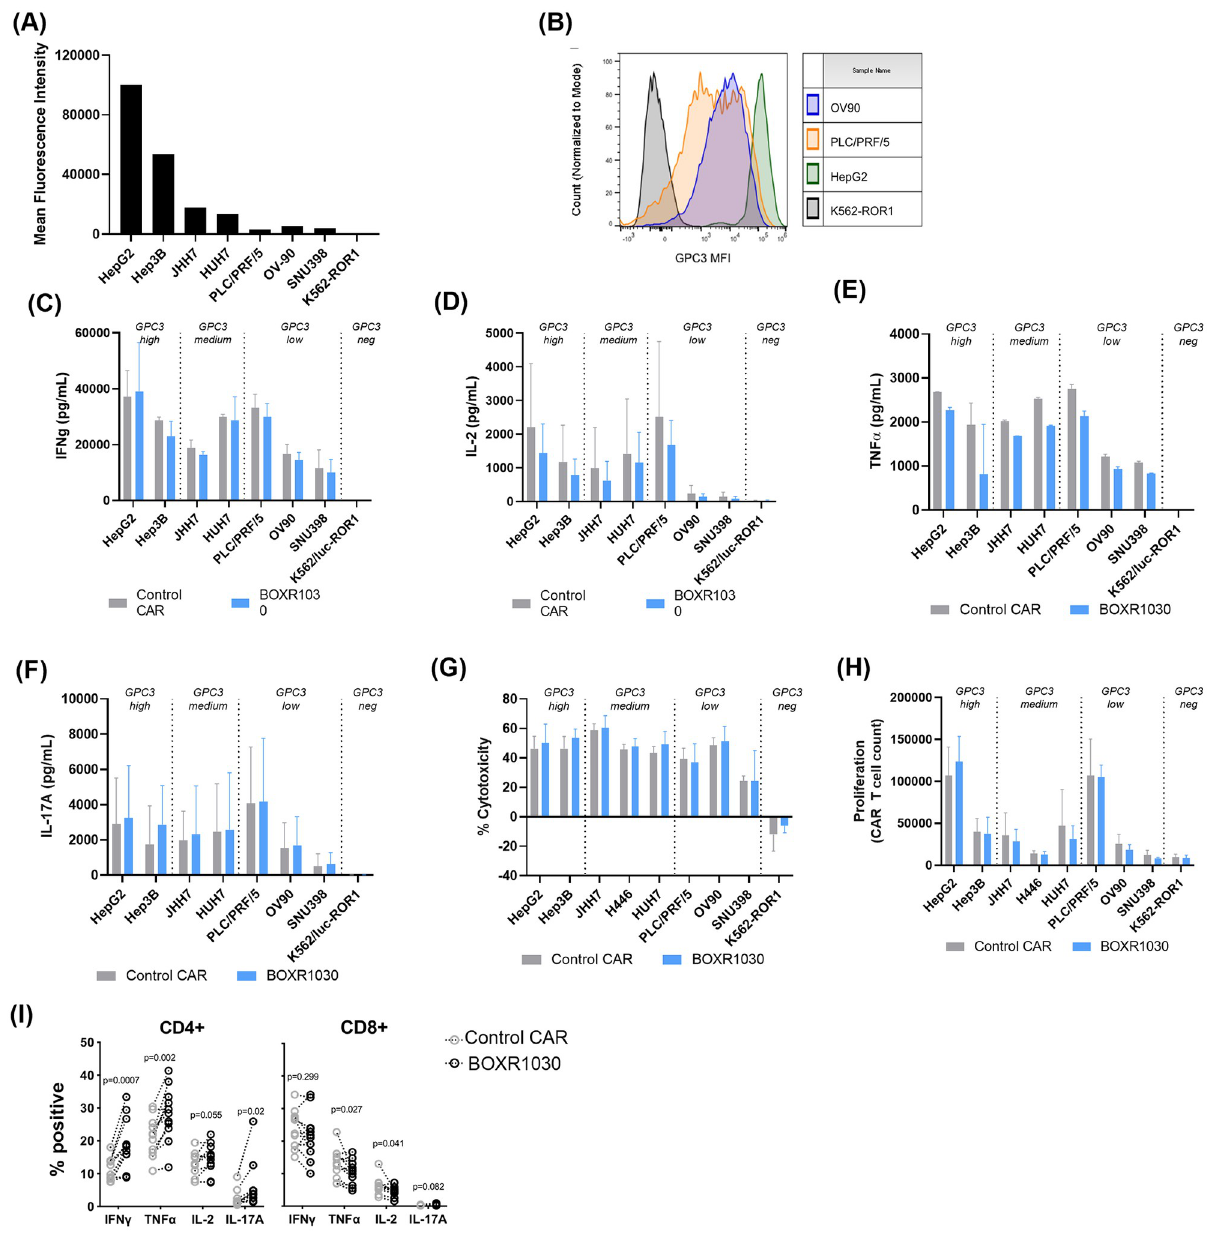
Fig 4. In vitro BOXR1030 activity. (A) Expression of GPC3 target antigen on target cell lines were measured by flow cytometry and represented as median fluorescence intensity (MFI). (B) Histogram plots of GPC3 MFI for selected cell lines. (C-F) T cell cytokine release of BOXR1030 and control CAR T cells was measured by ELISA following co-culture with target cell lines for 24 hours. Results for IFN-g (C) and IL-2 (D) are the averages across 3 donors, and error bars indicate SD. Results for TNF-a (E) and IL-17A (F) are for a single donor, and error bars indicate SD between technical replicates. (G) Target cell cytotoxicity was measured with a luciferase-based assay, and percent cytotoxicity was normalized to samples treated with untransduced T cells following 24 hours of co-culture (n = 3 donors, error bars indicate SD). (H) T cell proliferation was evaluated after a 7 day incubation with target cell lines. CAR+ T cell counts were measured by flow cytometry. (n = 3 donors, error bars indicate SD). (I) Intracellular cytokine levels were measured by flow cytometry in CD4+ and CD8+ T cells (n = 10, error bars indicate